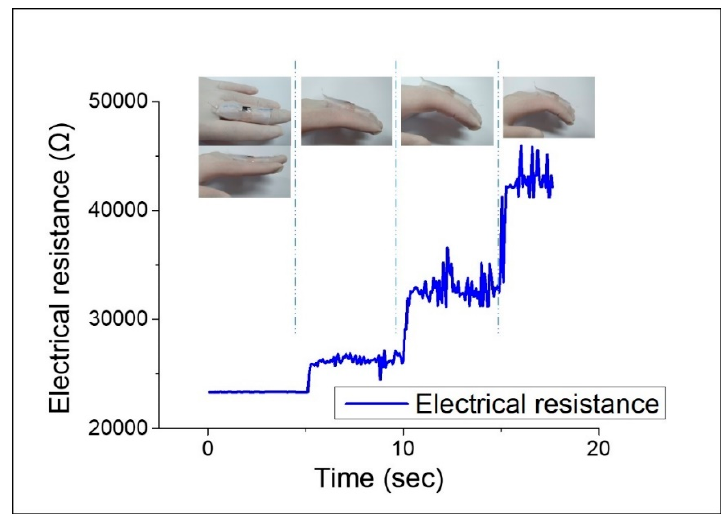
Figure 11. Motion detection of middle finger.